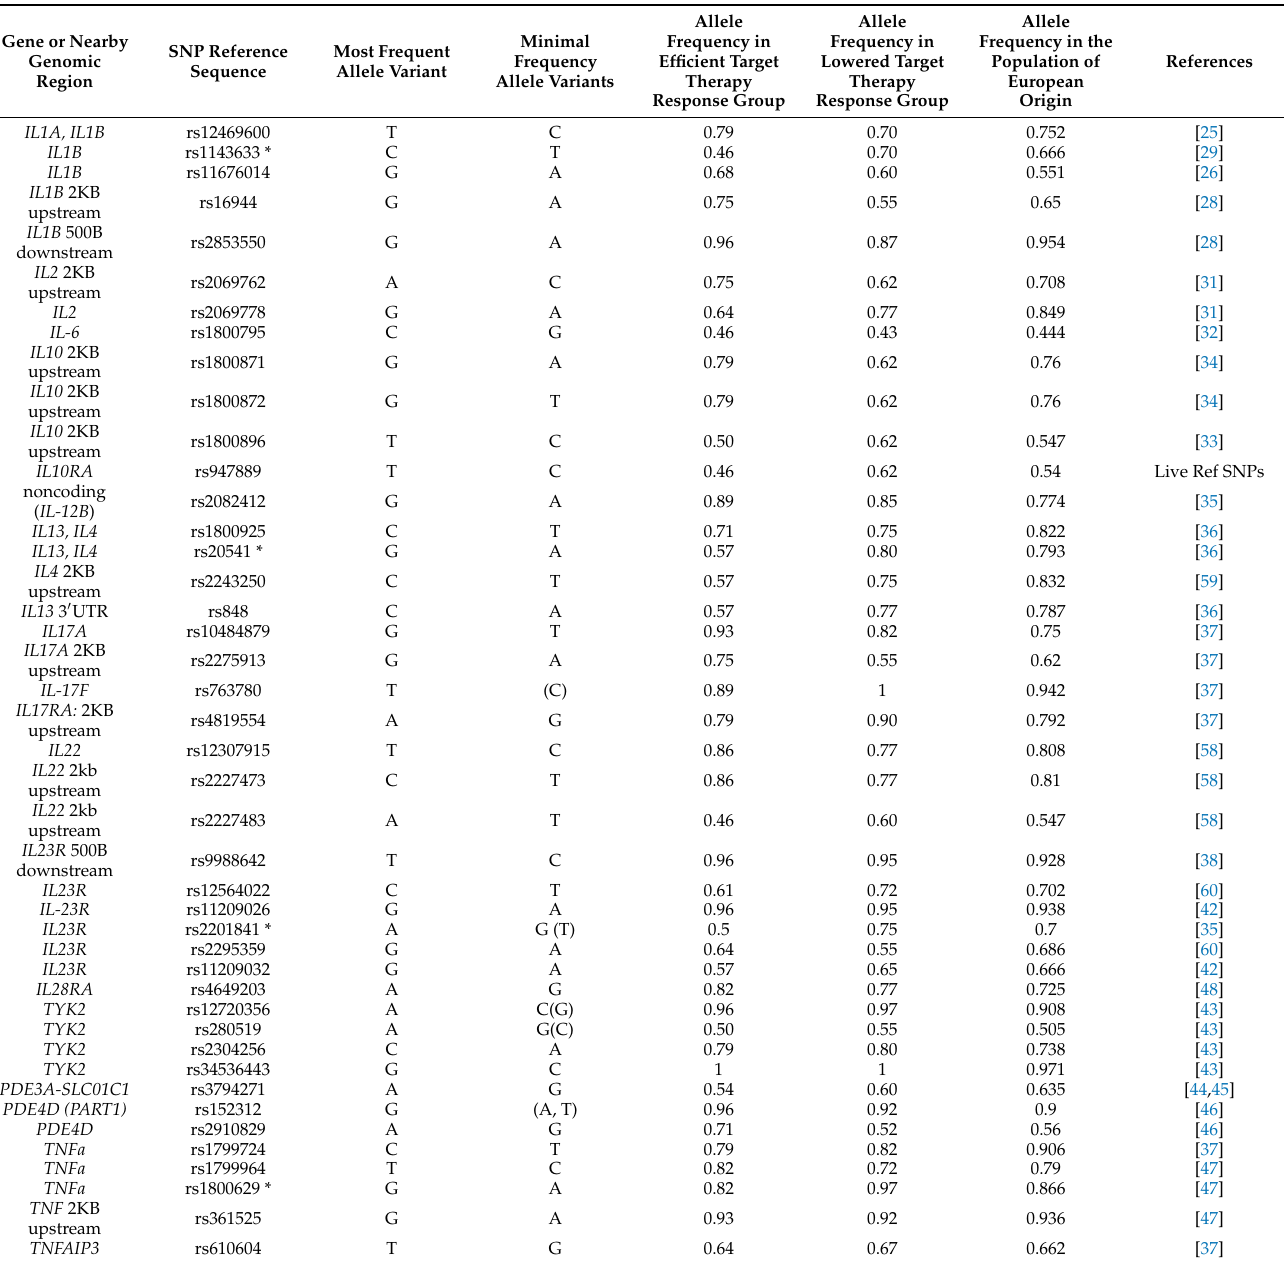
tive therapy outcomes had a coincidence probability less than 10 − 5 and a represented in Supplementary Table S1. The assessment of allele frequency differences at the pre-selected SNP sets between groups was conducted using the χ 2 probability test. Therein, we found that the consuming significance probability level was 0.05 (Table 1). The polygenic risk score was 38 SNP and was calculated according to Kisiel et al. [15]. AUC values were calculated with the R-package “pROC” software. The random Russian population sample of 15,776 individuals was consulted with Genotek Ltd. and accordingly genotyped to be used as the control group [24]. Table 1. The data obtained for 78 pre-selectedsingle-nucleotide polymorphisms(SNPs) [25–60] in patient groups with advanced and lowered target apremilast therapy clinical outcomes. SNP with statistically significant differences are labeled with a star *. The population was from European origin and were healthy. The“1000 Genomes” project is shown for